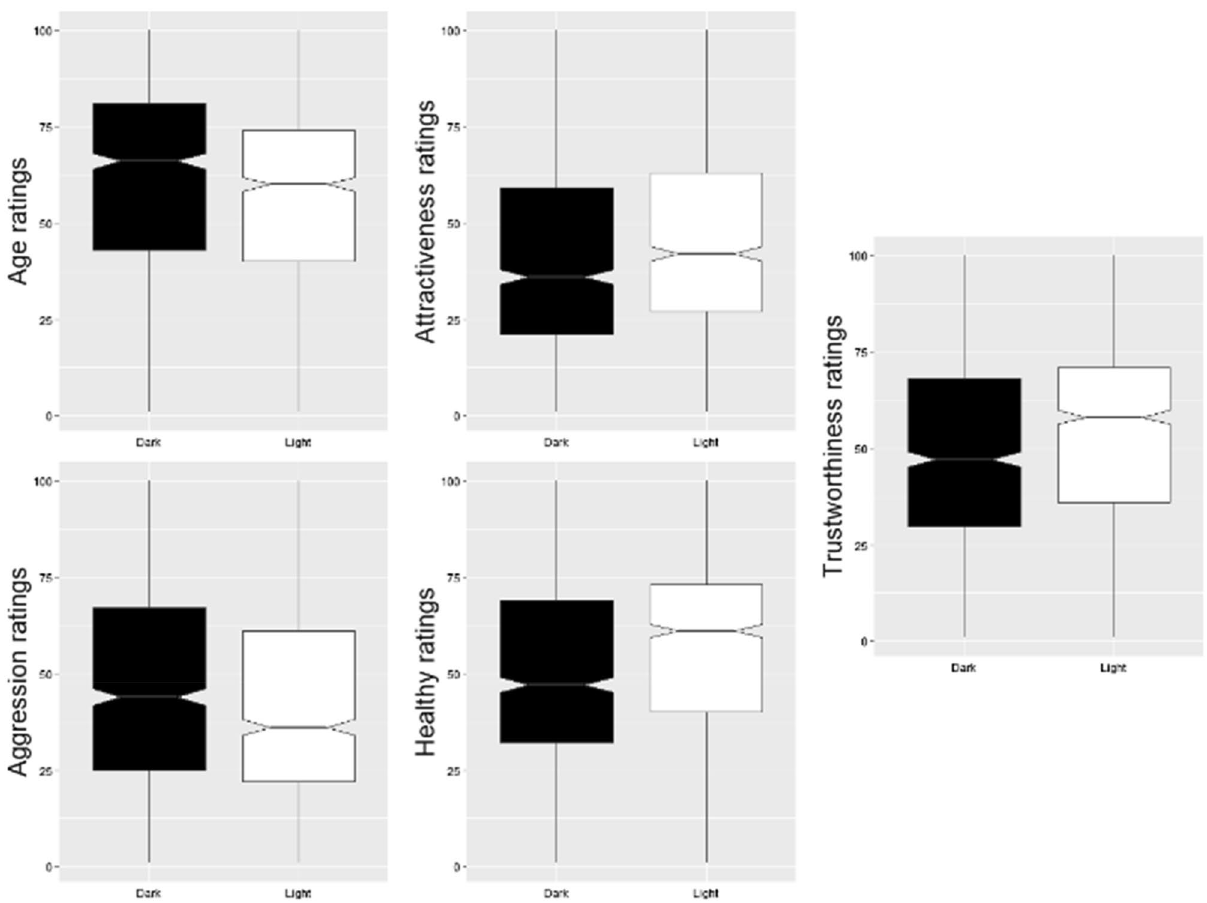
Figure 2. Comparison of ratings for each dependent variable in stimuli with dark or bright sclera. Whiskers represent range. Middle lines represent the median. Notches show confidence intervals (median + /− 1.58*IQR/ sqrt(n)).